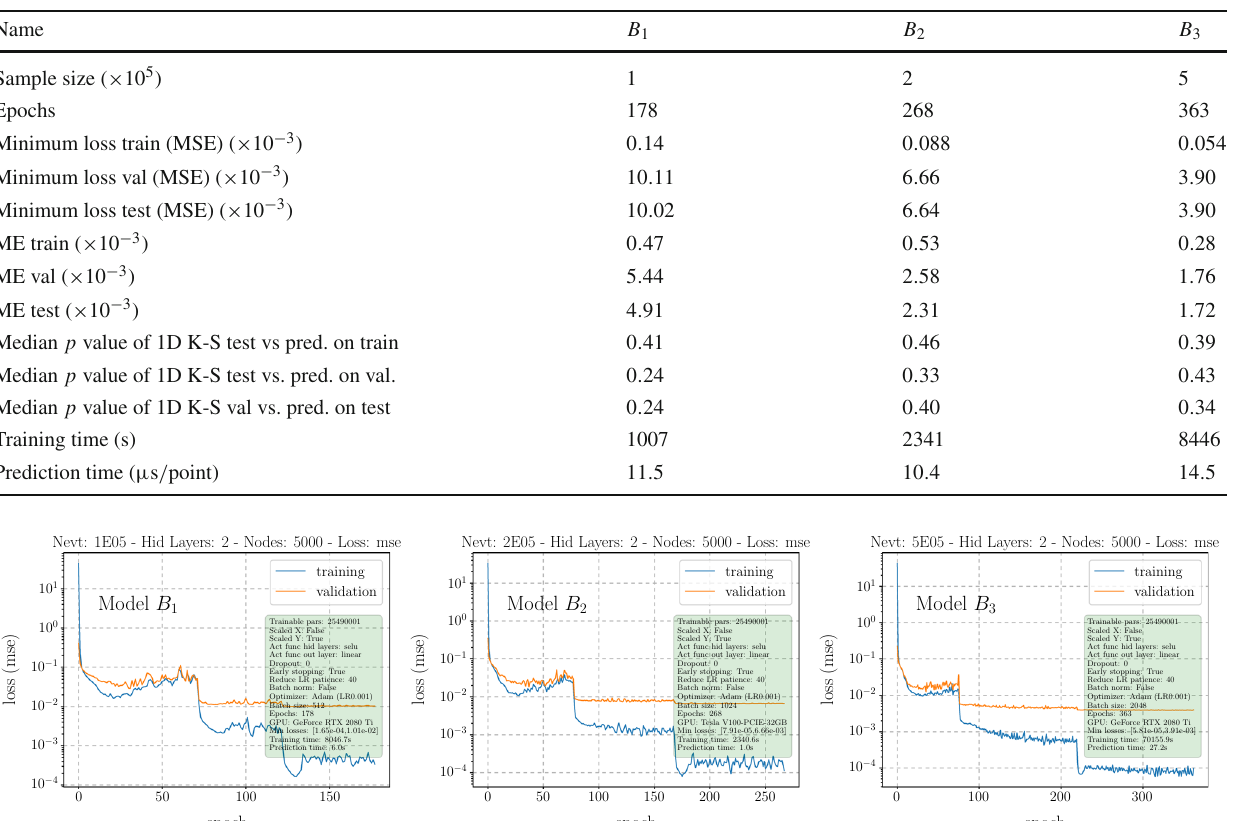
training set using the same batch size used in training, and evaluating on a Nvidia Tesla V100 GPU with 32GB of RAM. All best models have